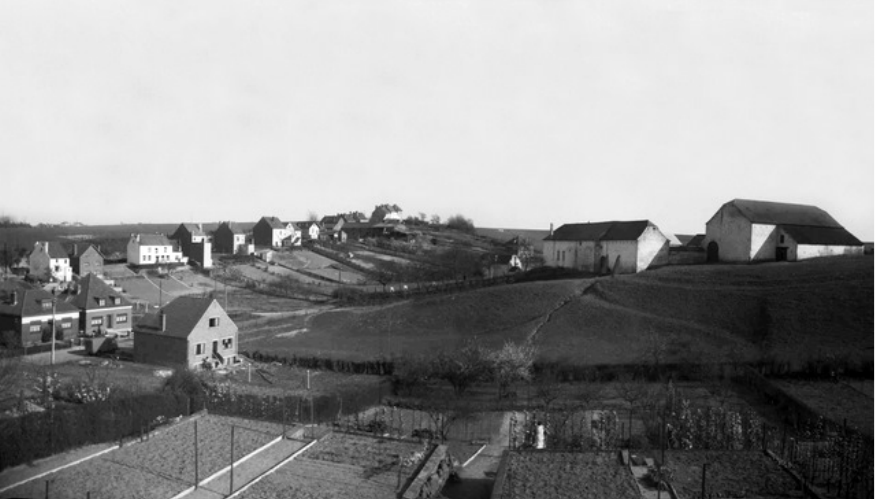
Figure 7. Neighborhoods of the Froidmont Farm in Rixensart. First houses under construction on Avenir Avenue, picture of H. Pilmeyer around 1954. Source: de Séjournet